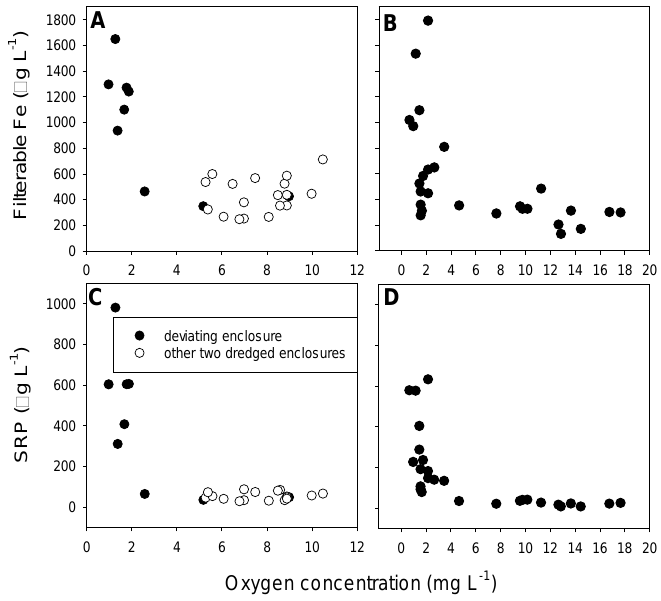
Figure D1. Measured filterable Fe concentrations as a function of the measured oxygen concentrations in solely dredged enclosures (Panel A ) and solely LMB-treated enclosures (Panel B ) and measured SRP concentrations as a function of the measured oxygen concentrations in solely dredged enclosures (Panel C ) and solely LMB-treated enclosures (Panel D ). For the dredged enclosures, the deviating one is indicated with black symbols, whereas the other two are indicated with open symbols.